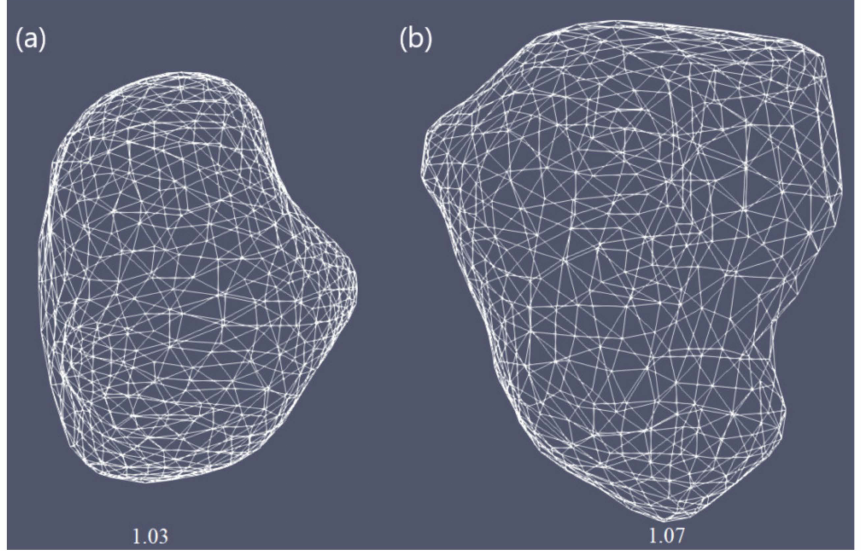
Figure 2. Three-dimensional simulation models corresponding to two liver tumors (triangulated surfaces) labeled as ( a ) 1.07 and ( b ) 1.03 in the 3D-IRCADb-01 database that contains several sets of CT scans of the patients